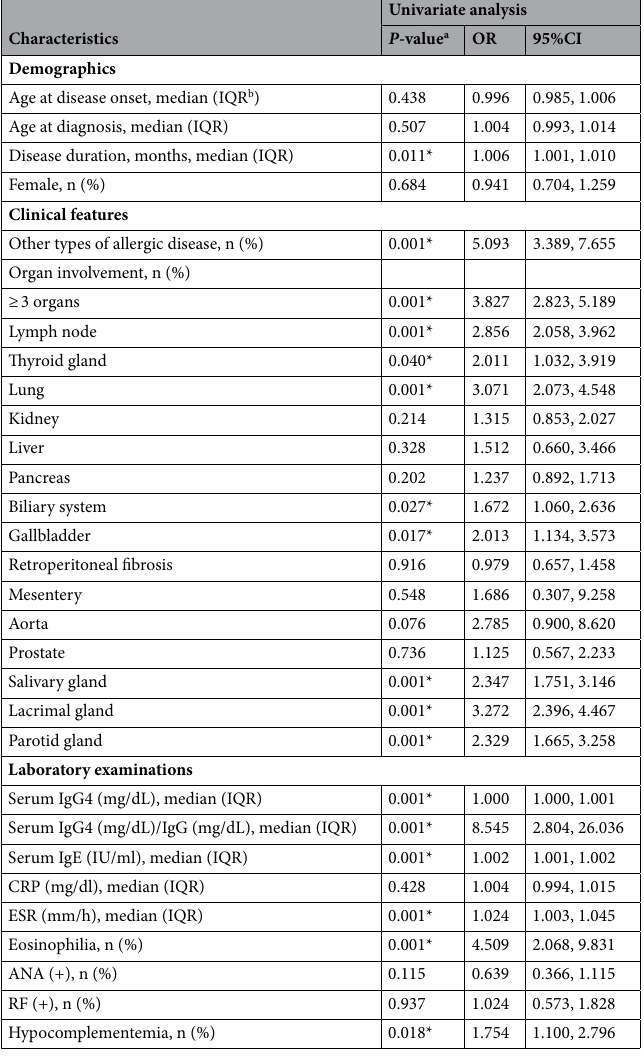
Table 3. Univariate analysis of logistic regression of risk factors for IgG4-RD patients complicated with AR or CRS (Case group). a *means P -value < 0.05; b IQR, interquartile